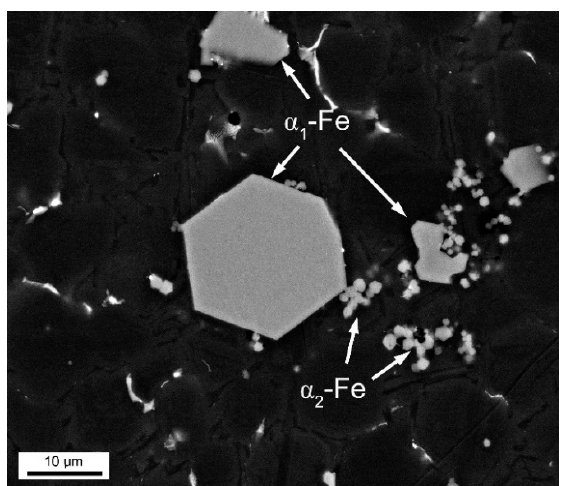
Figure 3. SEM micrograph of base alloy; α 1 -Fe and α 2 -Fe particles are indicated.